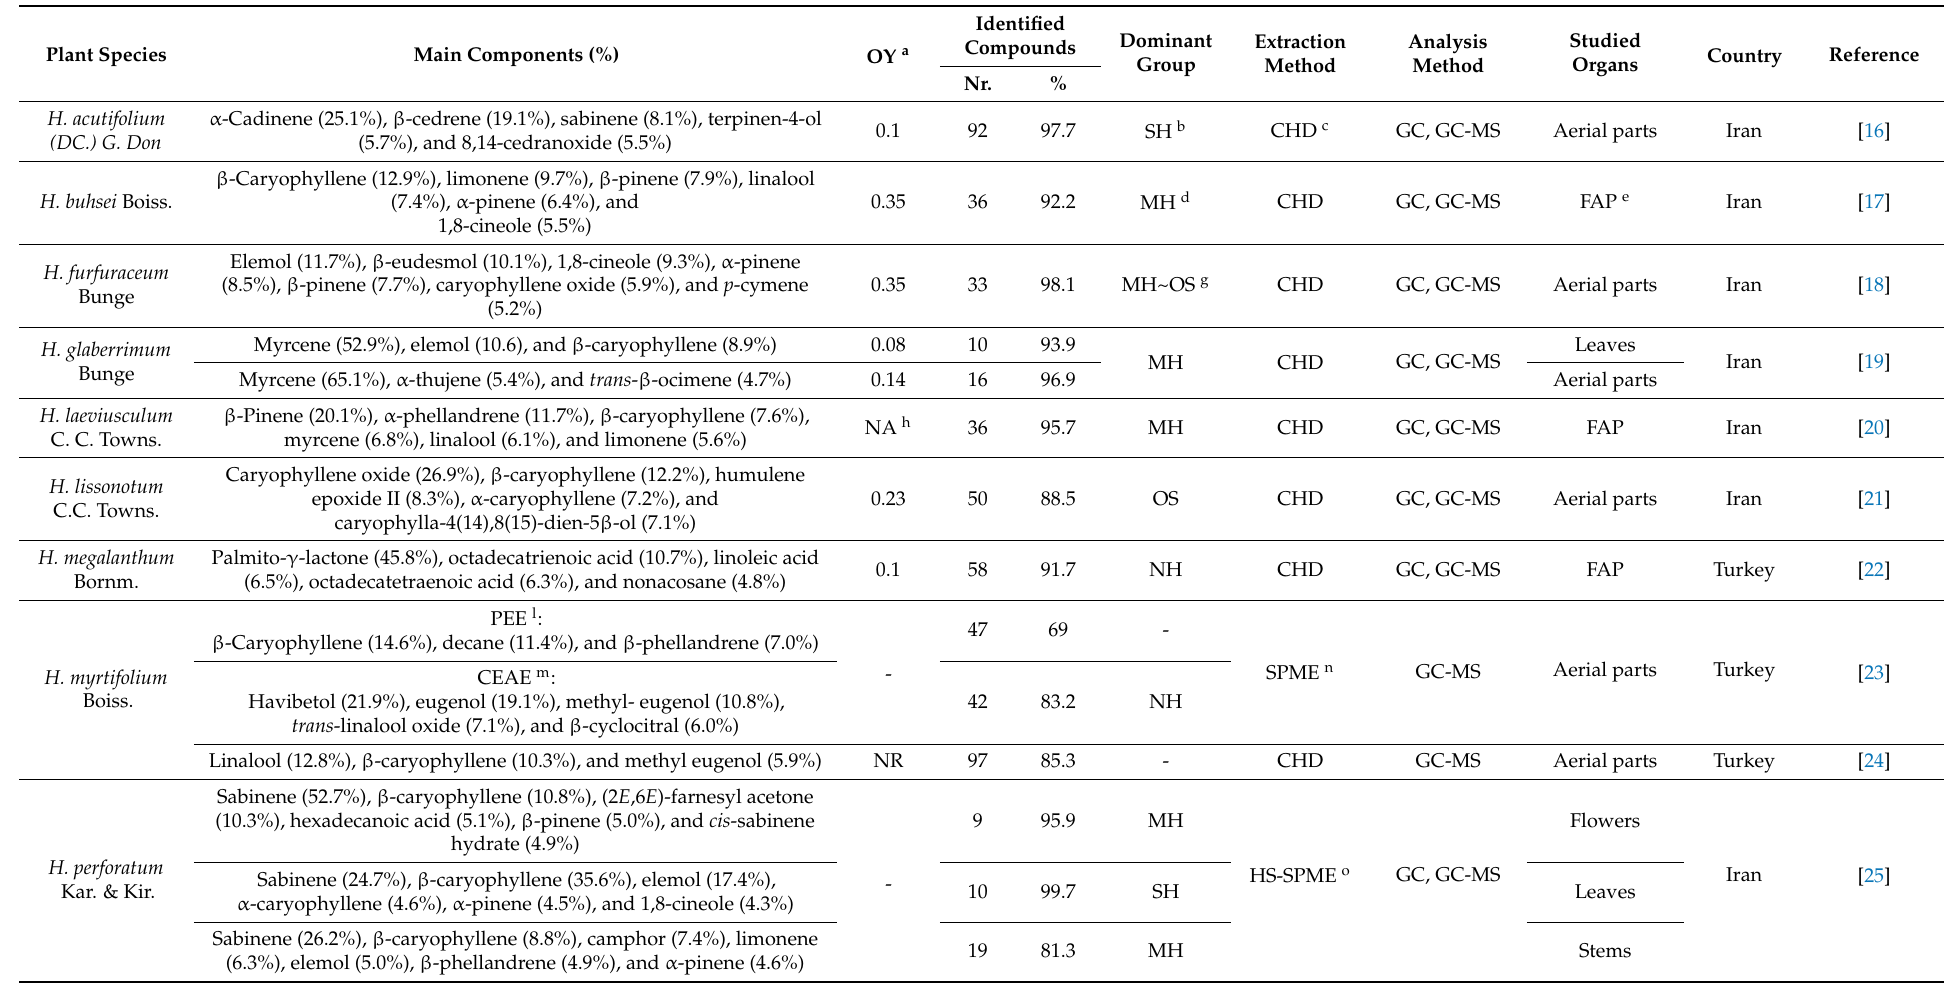
Table 1. Main volatile constituents from different species of Haplophyllum genus